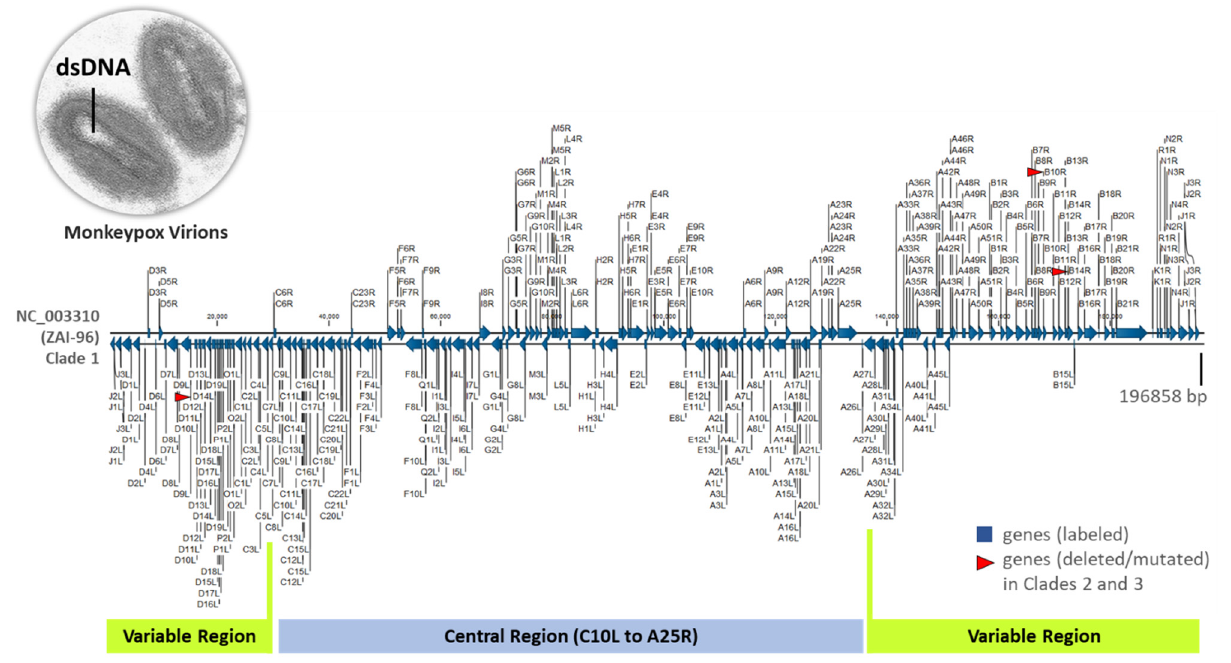
Figure 1. Representative Monkeypox virus genome. Linear, double-stranded, reference genome (NC_003310), ZAI-96-I-16 (MPV-ZAI) isolate from a patient during the 1996 outbreak in Zaire. The 196,858-bp sequence encodes 190 open reading frames (ORFs) with a highly conserved central region and terminal variable regions sealed in hair-pin loops on the ends. The triplet-coded, alpha-numeric nomenclature of the genes represents the Hind III restriction endonuclease fragments (alphabets), the n th gene (number) counted from the left of a fragment, and the direction of transcription (R: rightward, L: leftward). Notably, three genes are deleted (D14L) or mutated (B10R and B14R) in the less virulent, prototypic Western African MPXV isolate (SL-V70) (red arrow heads) [8–10].